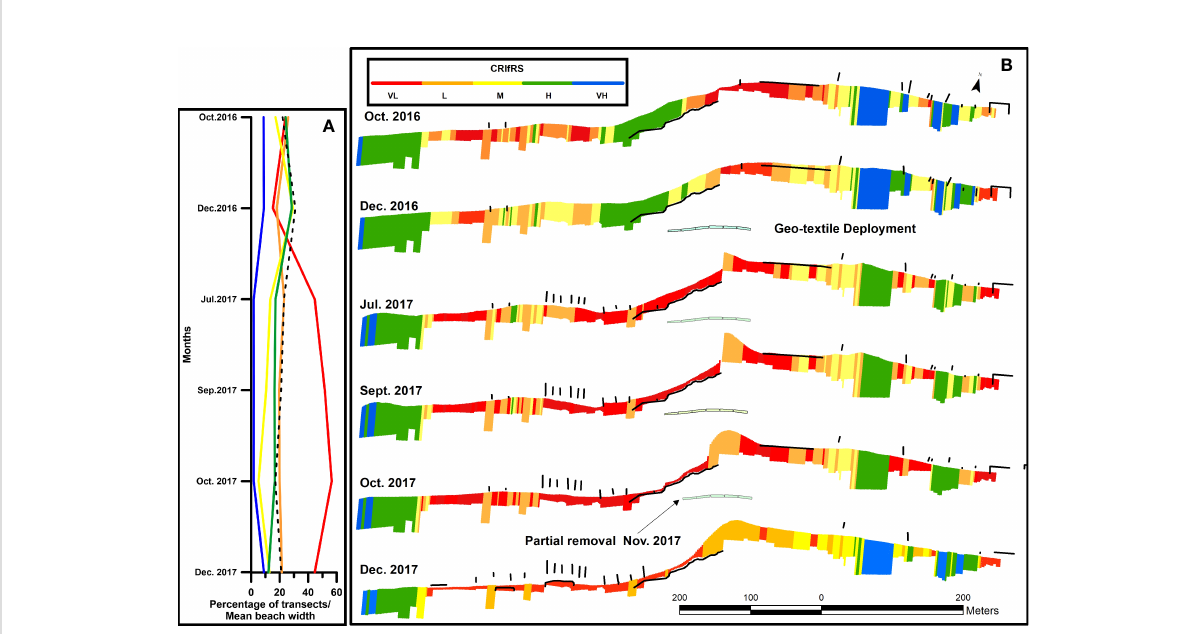
FIGURE 9 (A) CRIfRS assessment for Punta San Miguel, expressed as the percentage of transects for the fi ve different categories (Very Low in red, Low in orange, Medium in yellow, High in green and Very High in blue) and mean beach width value (dashed black line) along the study period (B) . Spatial distribution of the CRIfRS along the study period with the deployment of structures (black lines) and the geo-textile structure -July 2017- and partial removal of the western section -November 2017- (right